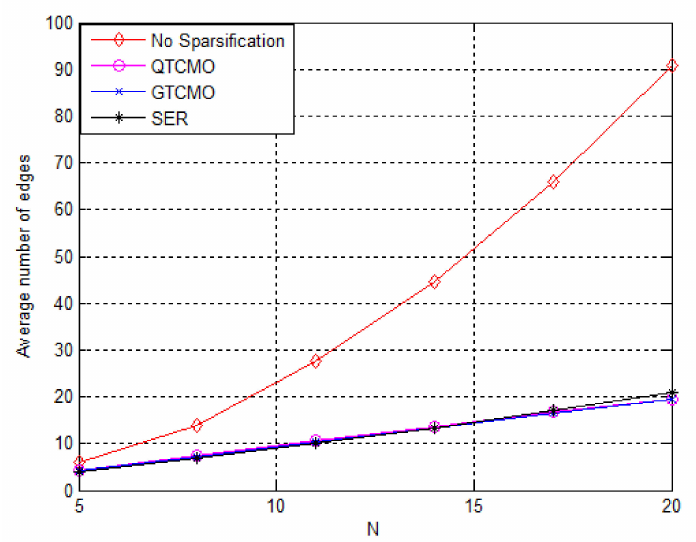
Figure 6. Average number of edges for different N